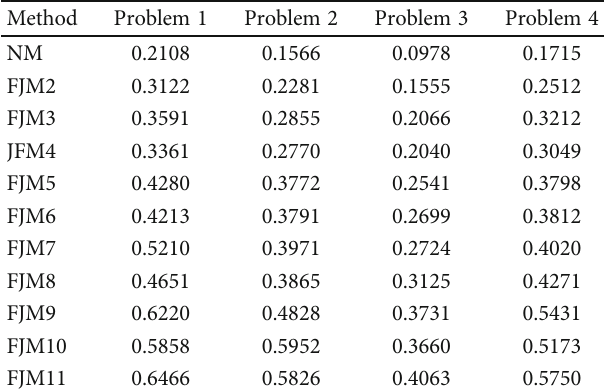
Table 9: Values of FJC1 for case n = 100 .